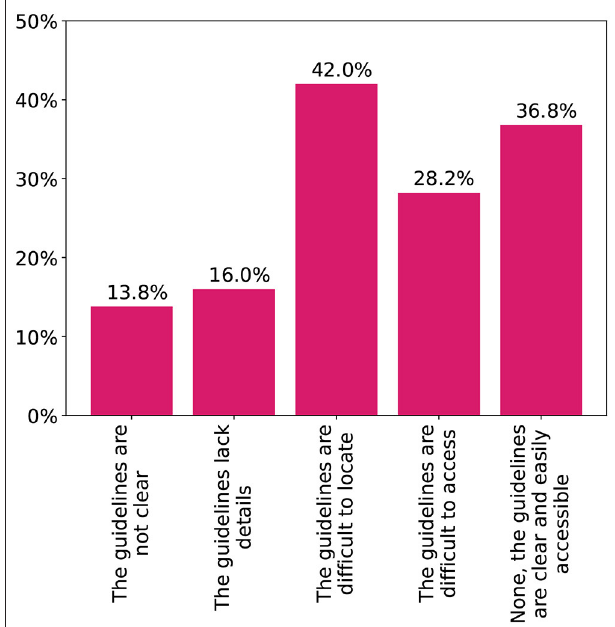
FIGURE 3 | Difficulties participating physicians faced with the local adult vaccination guidelines.